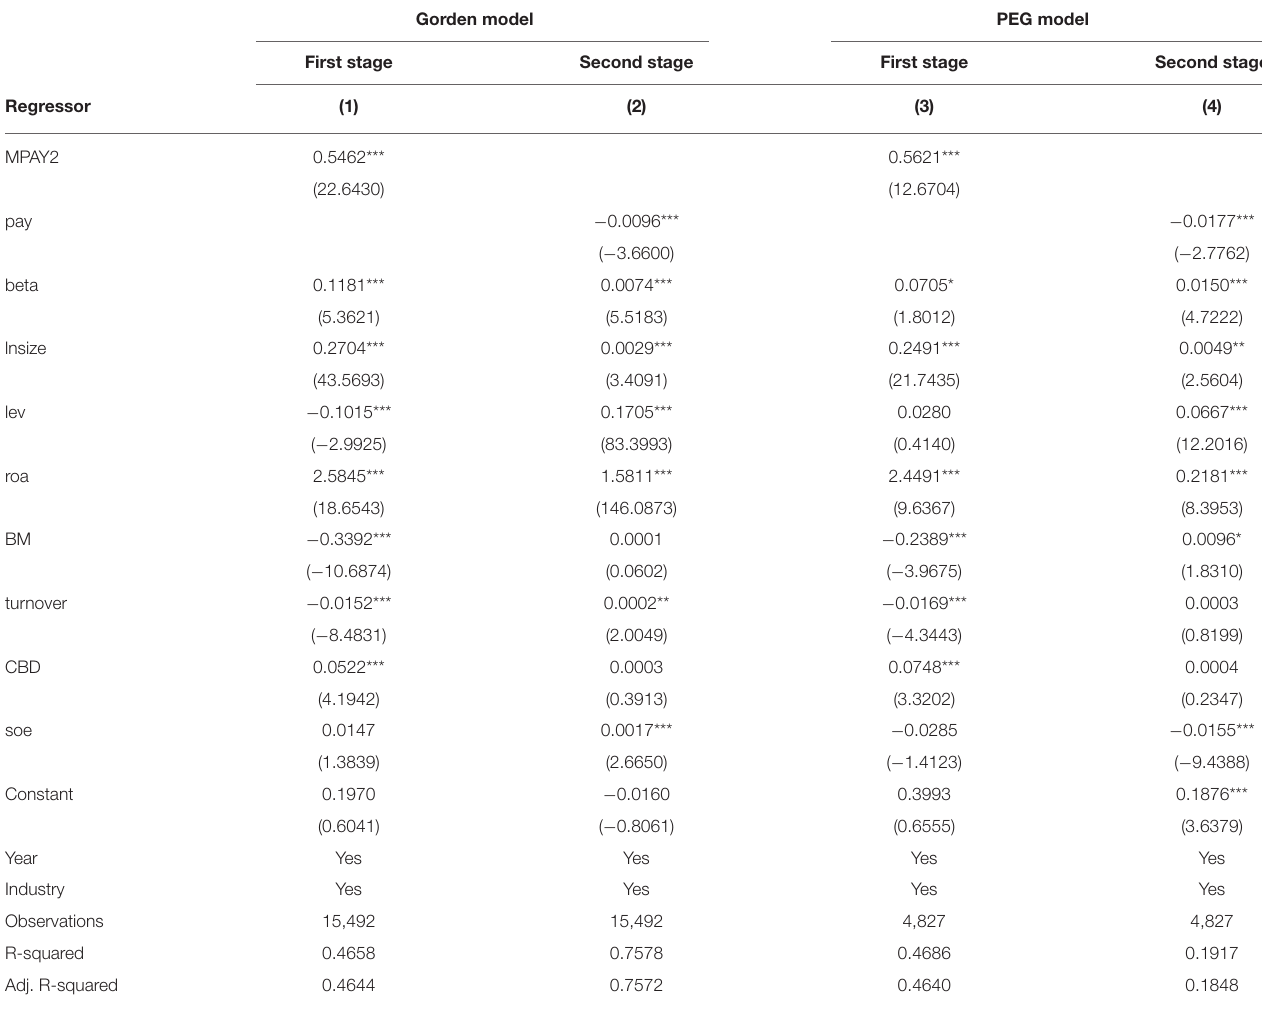
TABLE 7 | Endogeneity problem: